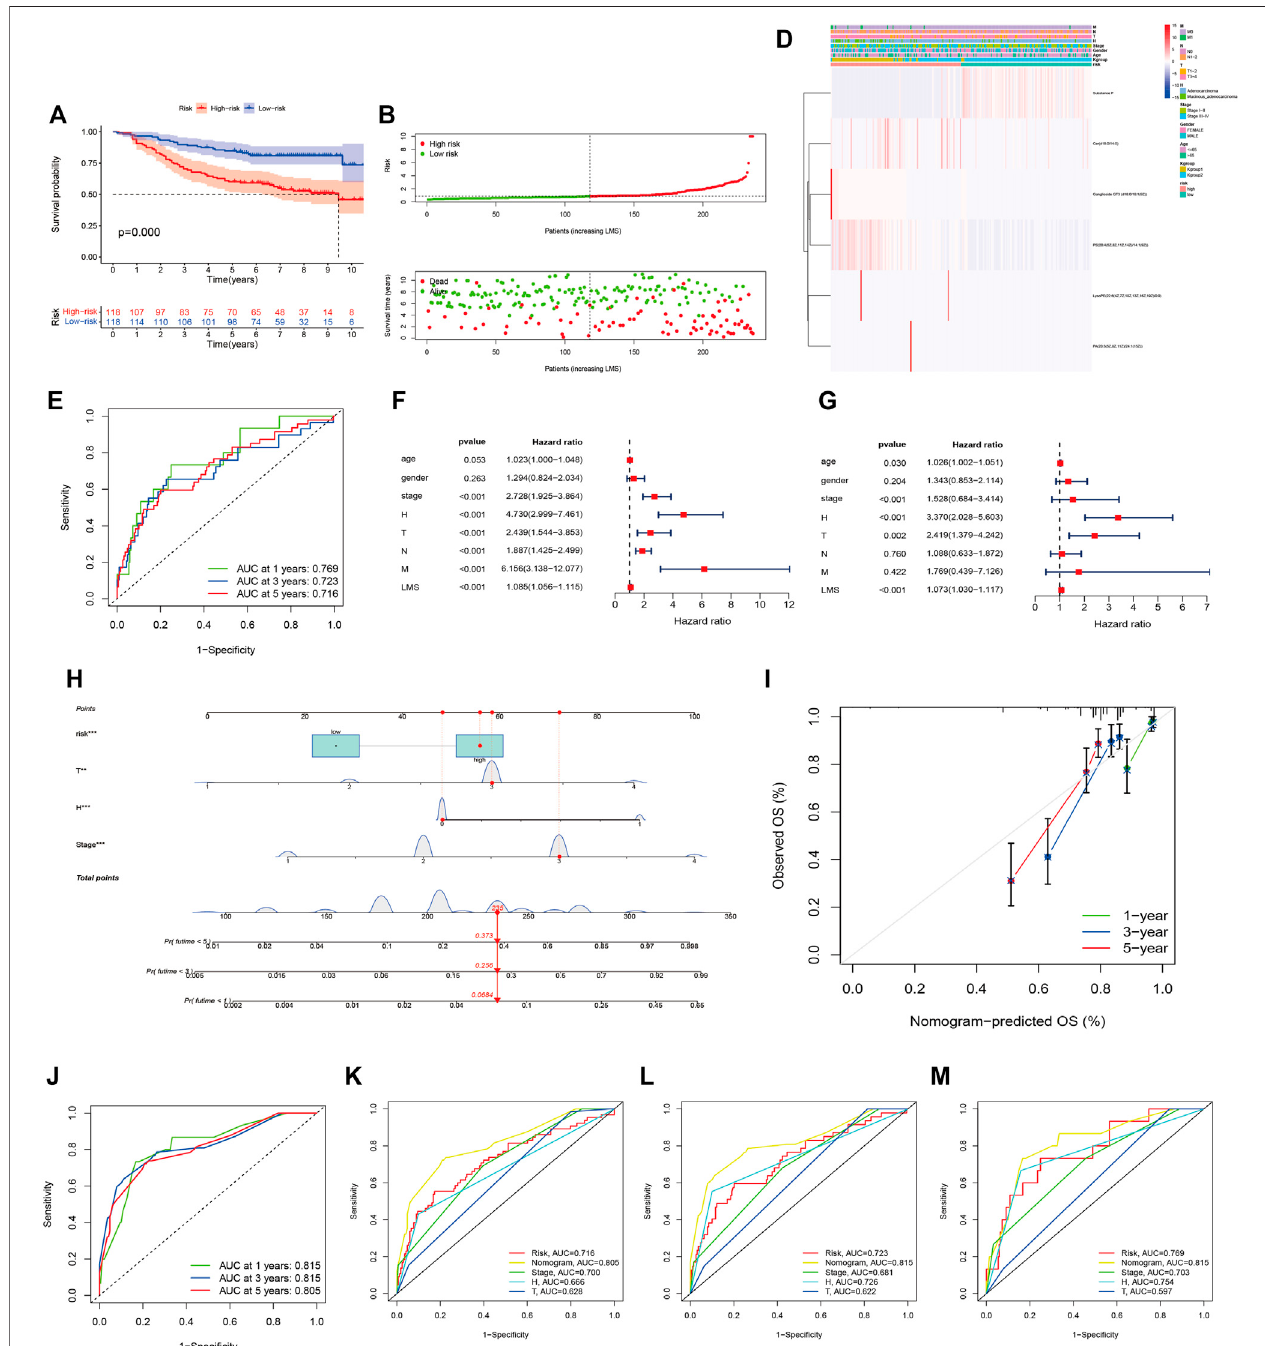
FIGURE3| Thesix-lipid-metaboliteprognosticsignatureistherobustindependentprognosticfactor. (A) :TheK-Msurvivalcurvesbasedonthesix-lipidmetabolite prognostic signature. (B) : The scatter plot showing the correlation between the JLUFH CRC patients ’ survival status and LMS. (C) : The dot plot representing the distributions of JLUFH CRC patients ’ LMS in the high- and low-risk groups. (D) : The clustering heatmap exhibiting the level variation tendencies of the six lipid metabolites of the prognostic signature in various clinical characteristics, K-groups (K-group1 and K-group2) and risk grouping (High- and low-risk groups). (E) : The one-, three-, and fi ve-year ROC curves ofthesix-lipid-metabolite prognostic signature. (F,G) : Univariate and multivariate independentprognostic analysisbased on thesix-lipid-metaboliteprognosticsignature,demonstratingthatpathologicalstage,histologicaltypeandLMScouldbedeemedastheindependentprognosticfactors. (H) : The composite nomogram consisted ofindependent prognostic factors. (I) : The one-, three-, and fi ve-year calibration curves of the composite nomogram. (J): The one-, three-, and fi ve-year ROC curves of the composite nomogram. (K – M) : The one-, three-, and fi ve-year multi-index ROC curves of the composite nomogram.